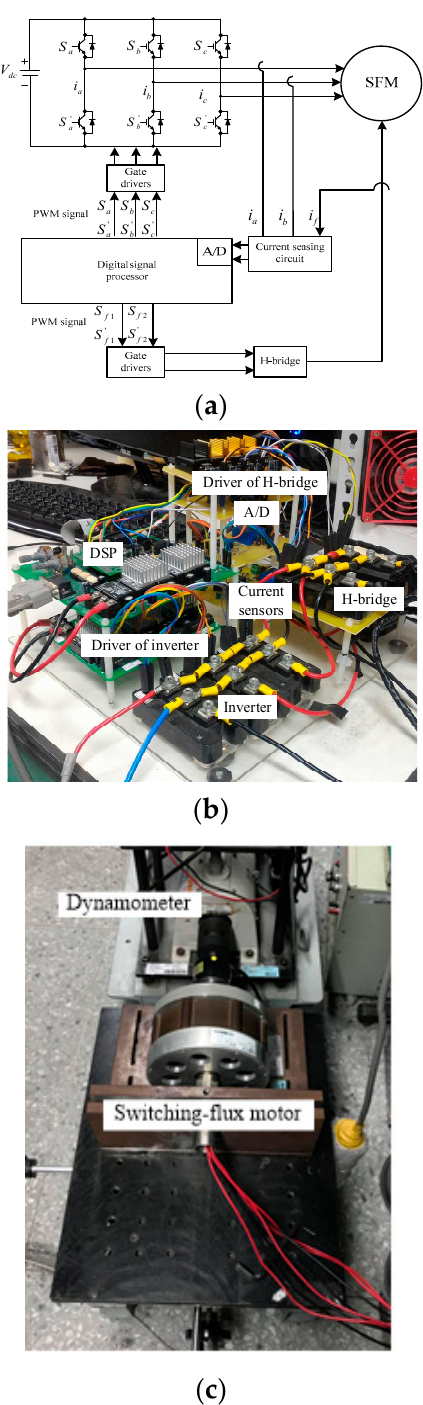
Figure 9. Photographs of the implementation system. ( a ) Block diagram, ( b ) hardware circuits, and ( c ) motor and dynamometer.